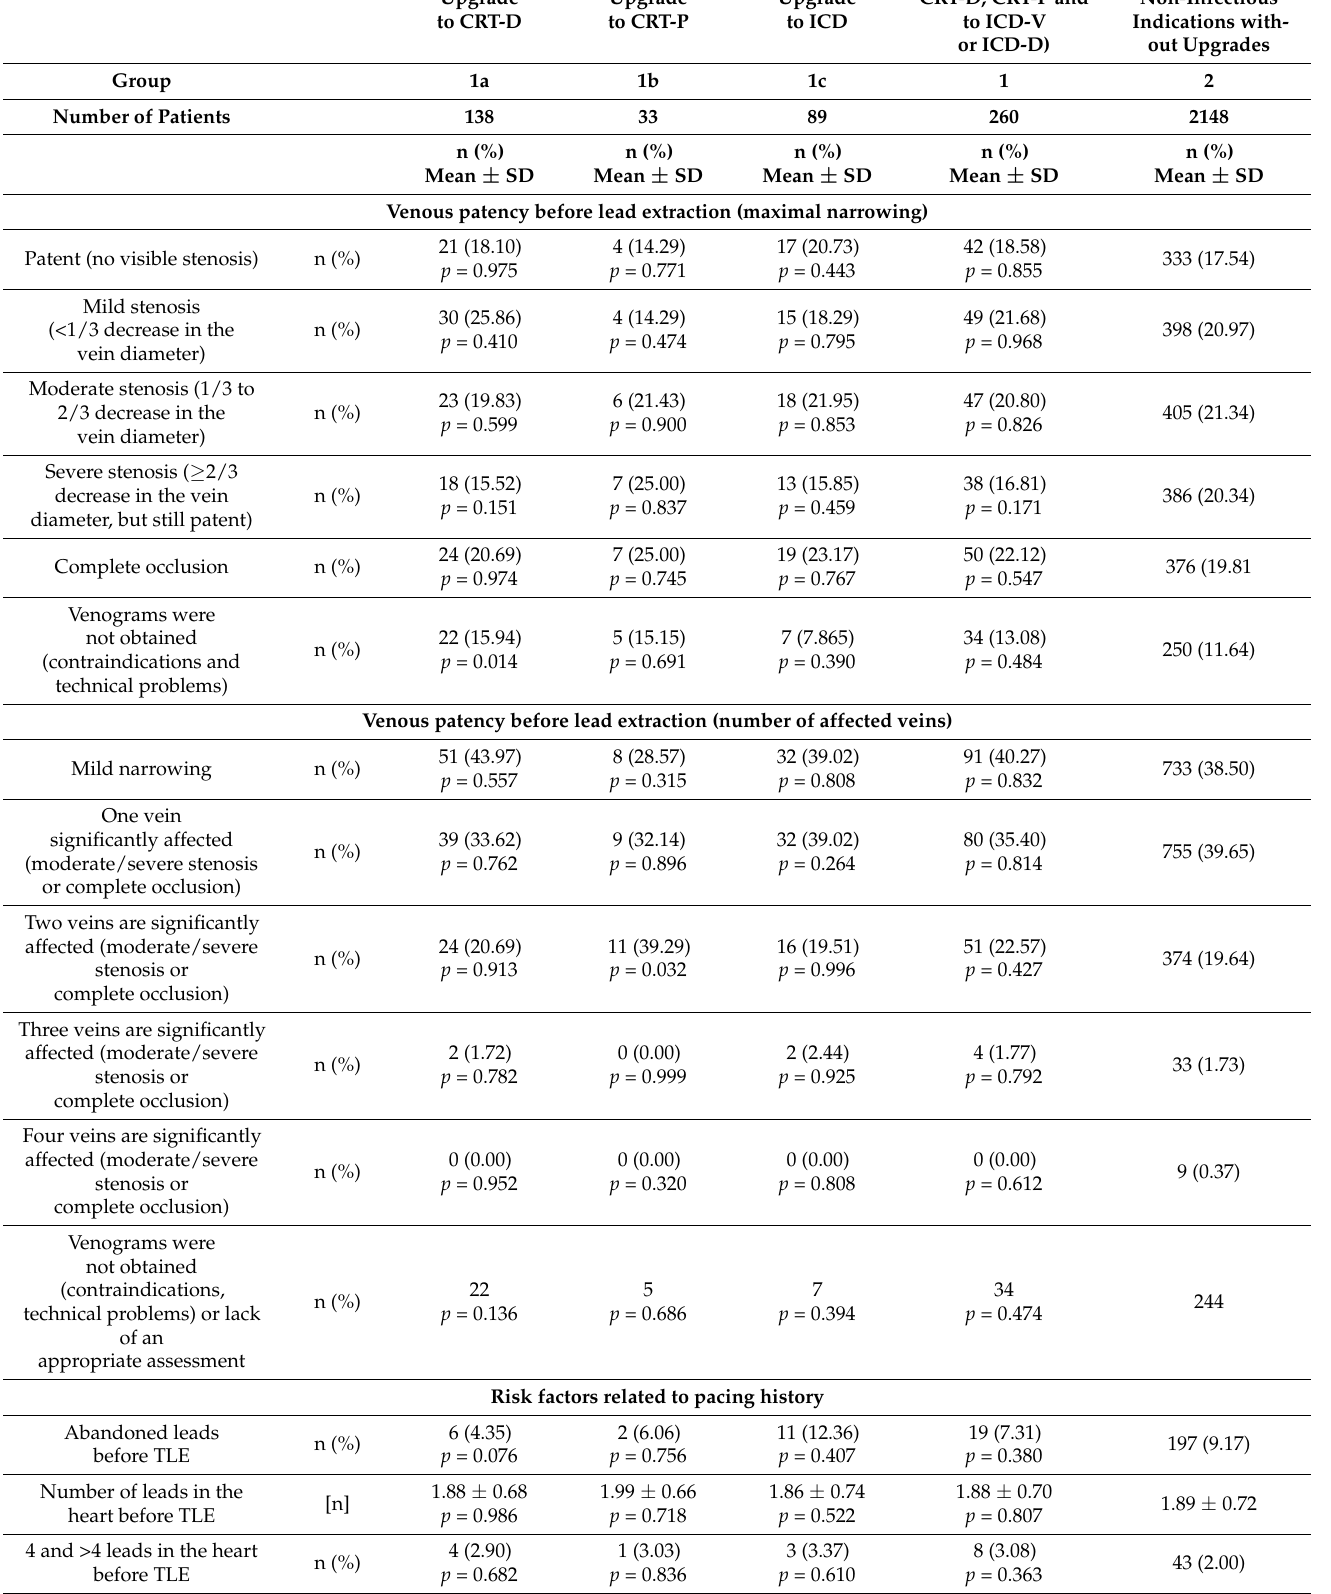
Table 2. Venous patency before lead extraction (maximal narrowing and number of affected veins) and risk factors for TLE complications and procedure